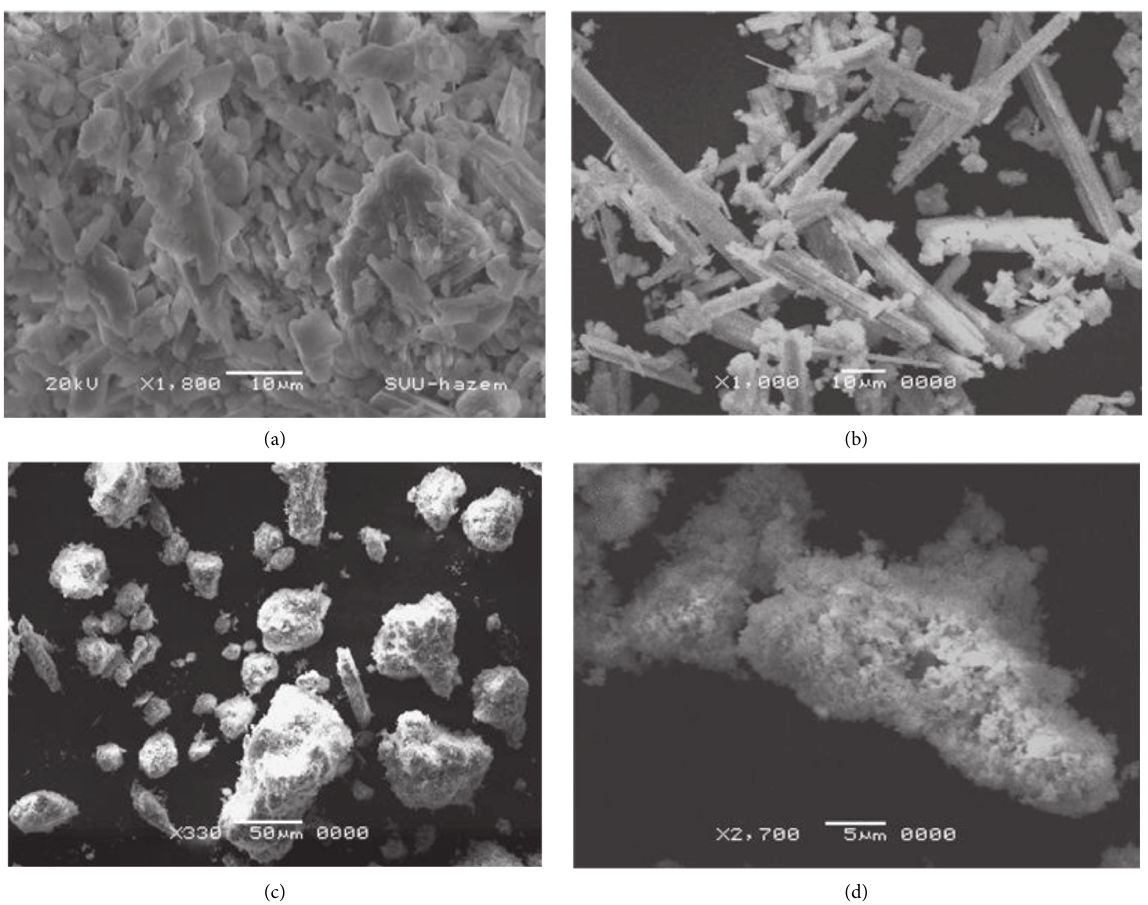
° C, and (d) CaTiO 3 obtained after